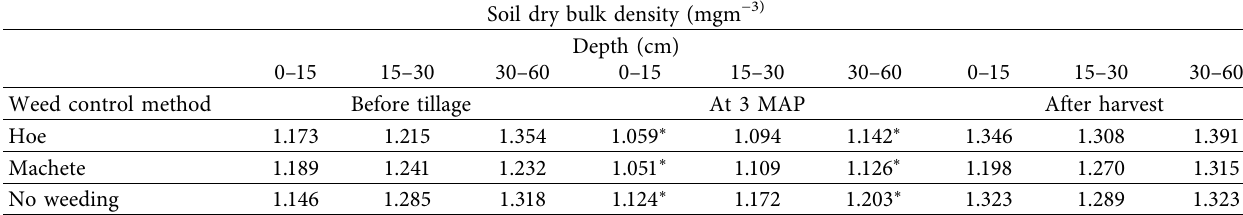
Table 3: Weed control method’s effect on soil dry bulk density.